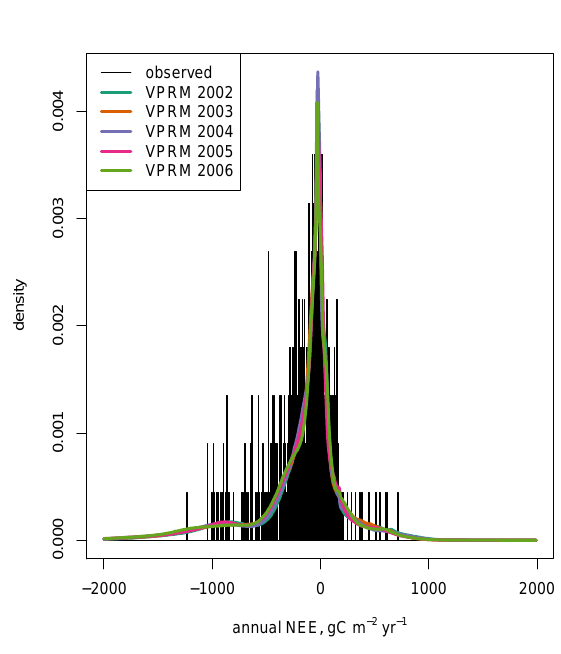
Fig. 6. Histograms of annually integrated NEE. Observations are the 2007 FluxNet synthesis gap-filled annual NEE.